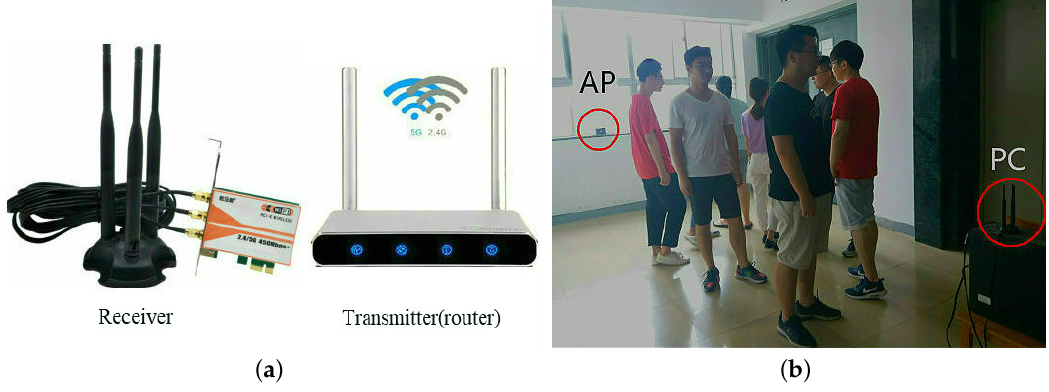
Figure 7. The experiments equipment and scenes. ( a ) receiver and router; ( b ) experiment scene.